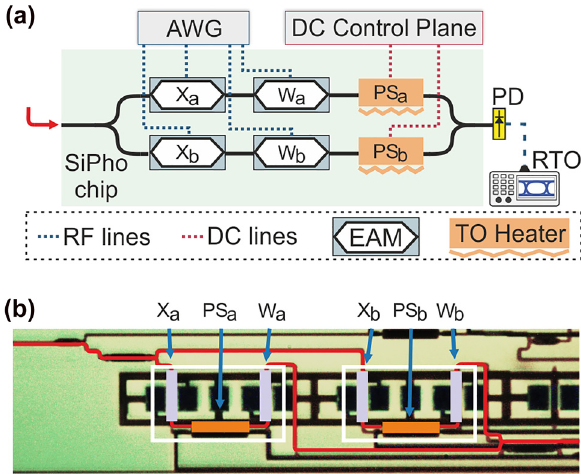
Figure 4: Experimental testbed: (a) Experimental setup established for the inference of the NN for the IRIS dataset classification. (b) SiPho processor employed for the NN